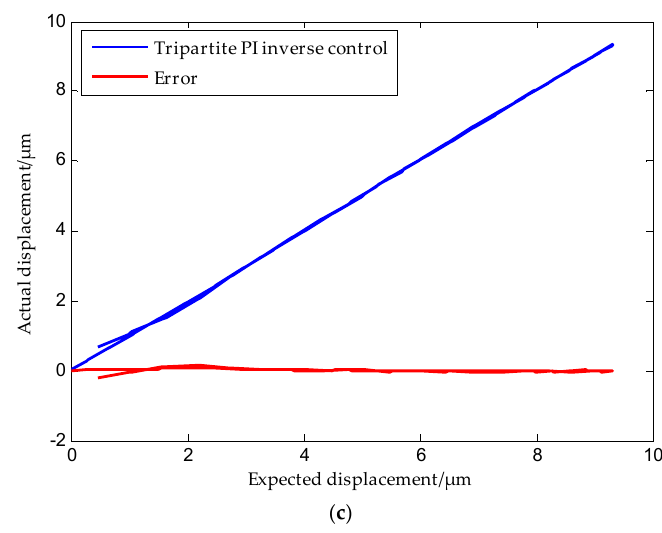
Figure 19. Positioning accuracies of three kinds of inverse models: ( a ) PI inverse model; ( b ) Preisach inverse model; ( c ) Tripartite PI inverse model.